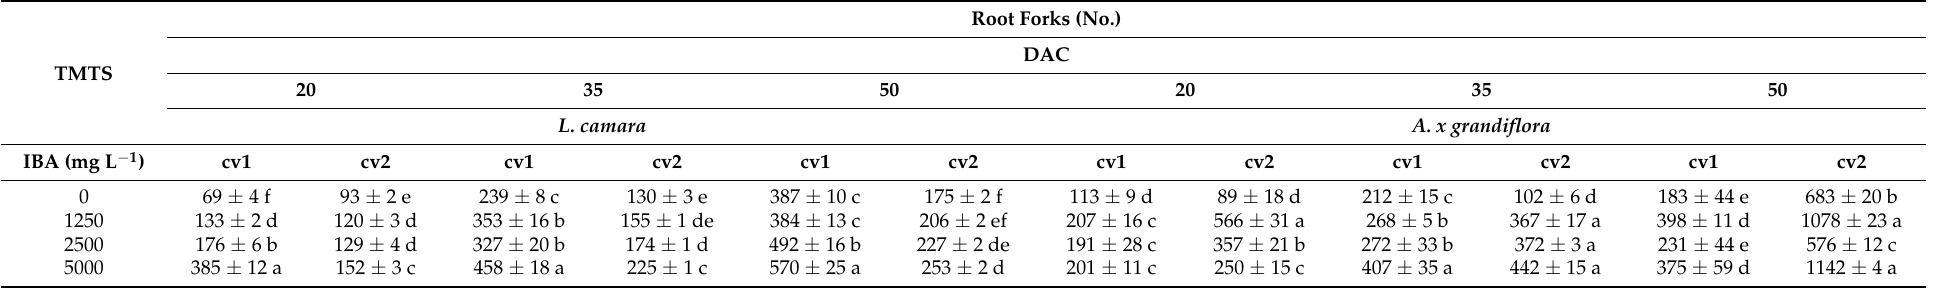
Table 4. Number of root forks per cutting in wild sage and glossy abelia at 20, 35 and 50 DAC, according to IBA concentration and